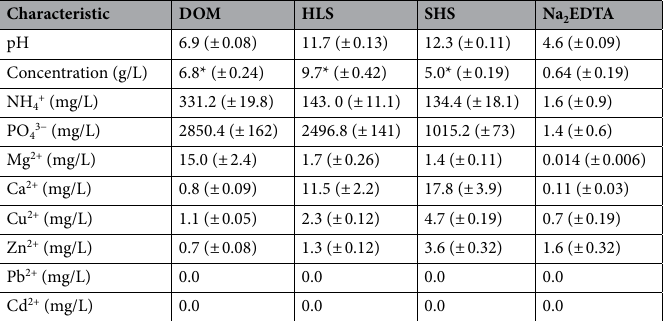
Table 2. Selected properties of WAs used for soil flushing (mean value, n = 3, ± standard deviation). *original DOM, HLS and SHS concentration (expressed as g of dissolved organic carbon per L) extracted from sewage sludge under conditions given in Table 1.